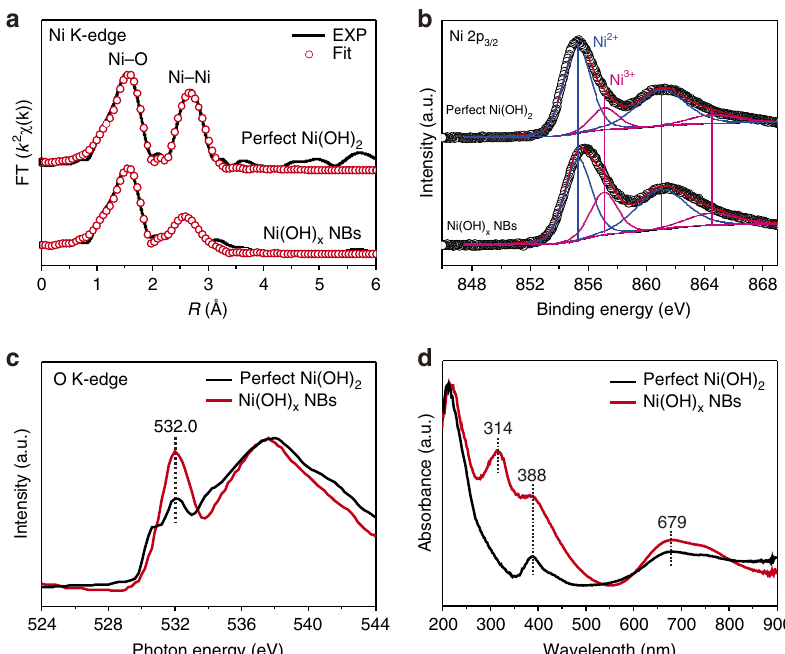
Fig. 4 Investigation of cation vacancies on Ni(OH) x NBs. a Ni K-edge Fourier transform EXAFS spectra and corresponding fi tting analysis for Ni(OH) x NBs and the perfect Ni(OH) 2 . b XPS analysis of Ni(OH) x NBs and the perfect Ni(OH) 2 in the Ni 2p 3/2 region. c O K-edge sXAS spectra of Ni(OH) x NBs and